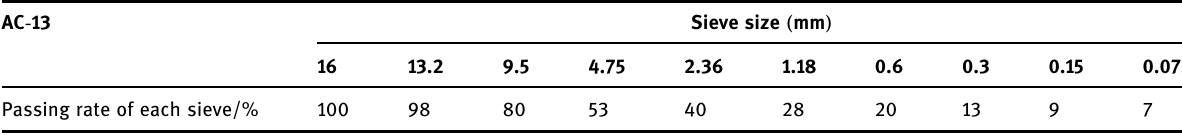
Table 1: Gradation of minerals AC - 13